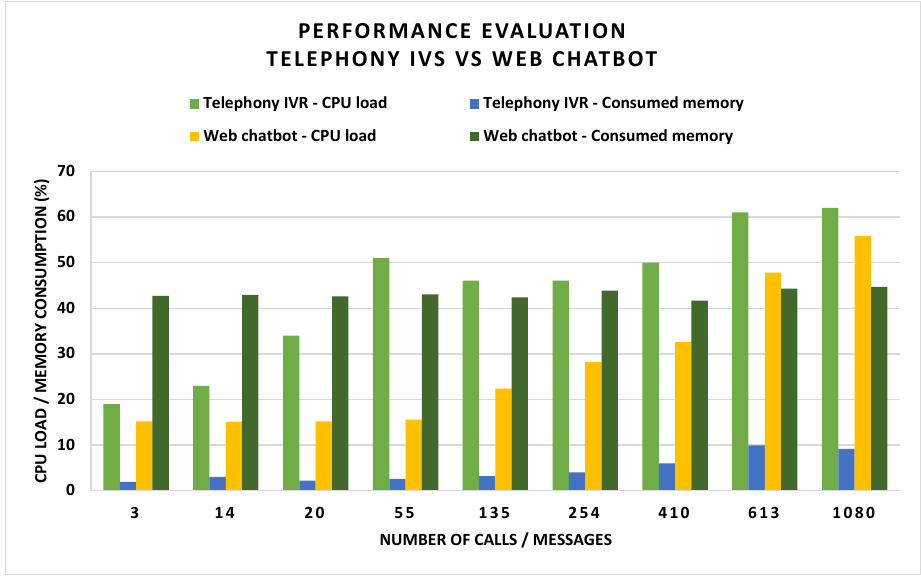
Figure 5. Resource consumption evaluation of the